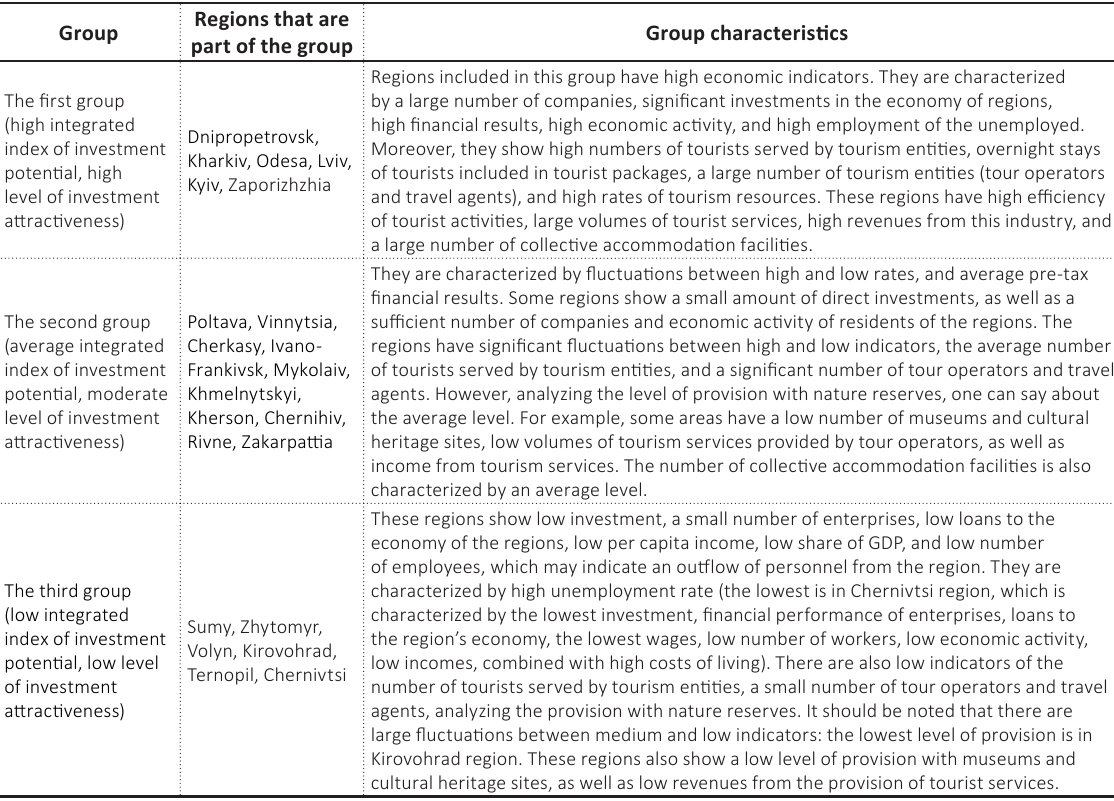
Table 2. Characteristics of groups of Ukraine’s regions according to the integrated index of tourist systems’ investment